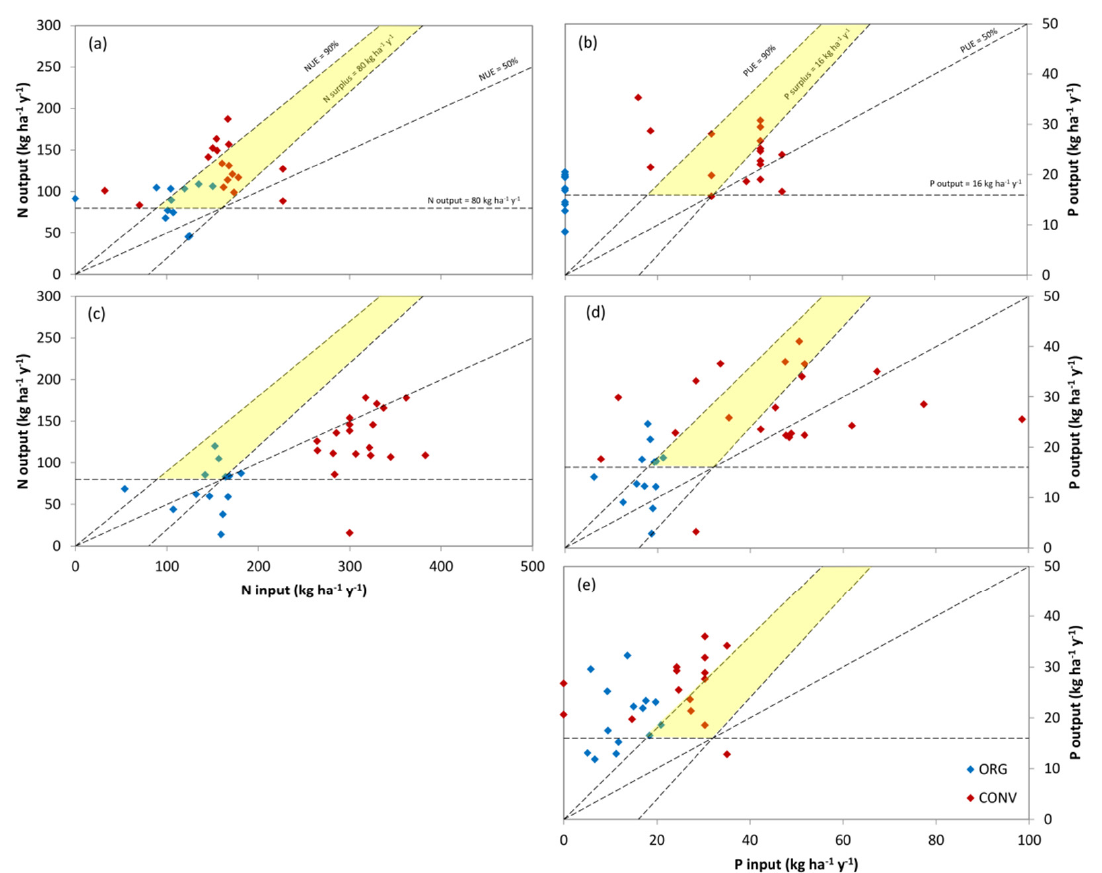
Figure 7. Graphical representation of nitrogen ( a , c ) and phosphorus ( b , d , e ) use efficiency under RF conditions for winter wheat ( a , b ), maize ( c , d ), and soybean ( e ). The lines corresponding to nutrient use efficiency (UE) = 0.90, desired maximum surplus, UE = 0.50, and desired minimum productivity delineate the “sustainability” area (in light yellow). Observations are clustered according to organic (blue points) or conventional (red points) agriculture management.